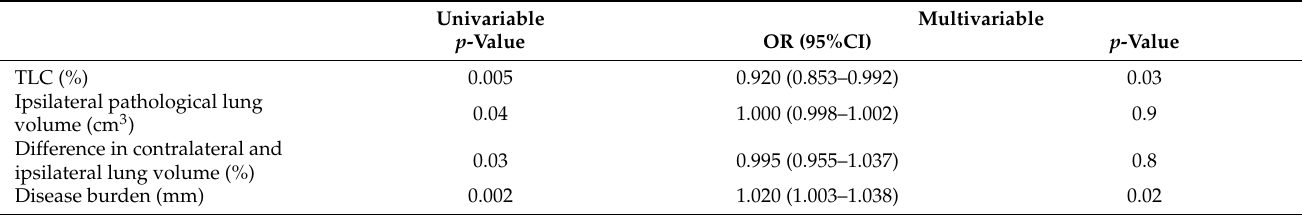
Table 3. Univariable and multivariable regression analysis.